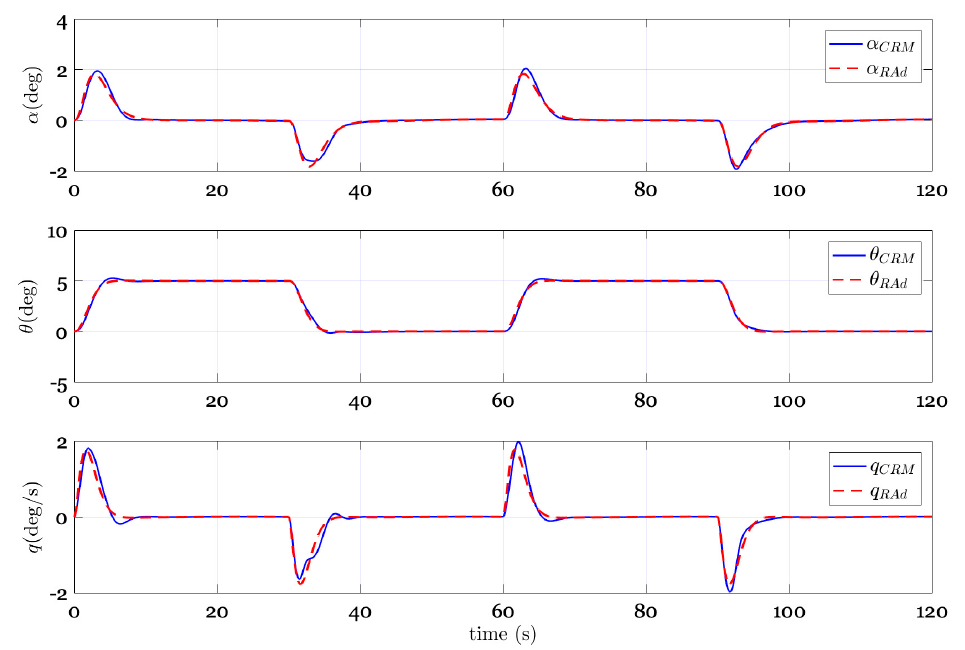
Figure 13. Aircraft response for closed-loop reference model (CRM) and robust adaptive controller with ρ λ = ρ θ = 10.